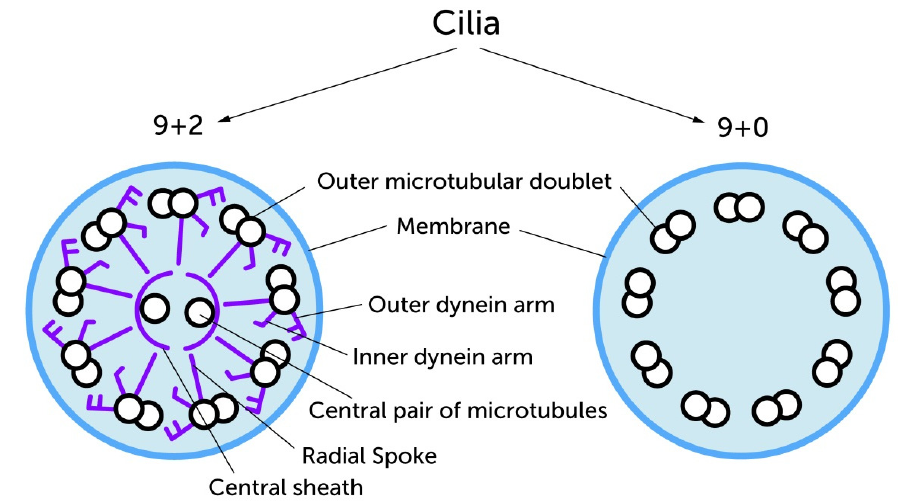
Figure 1. The early classification of cilia depended largely on di ff erences in ultra structure. The 9 + 2 microtubule arrangement is most commonly found in motile cilia which carry additional structural proteins in their axonemes especially the radial spoke, the inner and the outer dynein arms (purple colored) to perform their beating function. These structural proteins are missing in most of the primary monocilia. Both groups have in common that the basic framework is formed by microtubule doublets. Image modified from Takeda and Narita (2012)